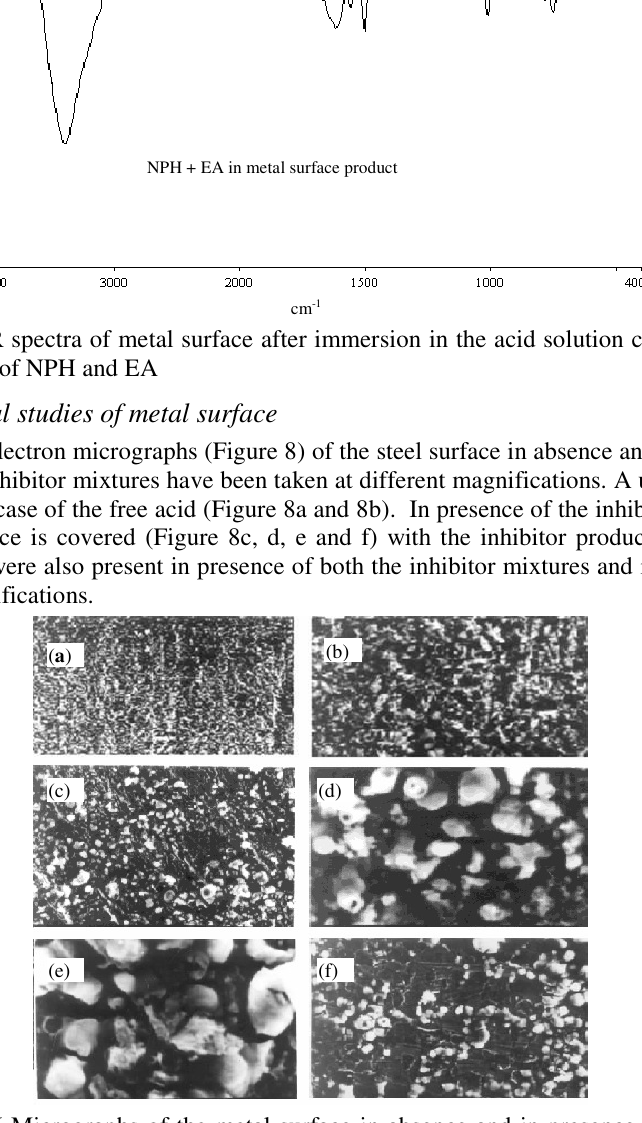
Figure 8. SEM Micrographs of the metal surface in absence and in presence of the binary inhibitor mixtures at different magnifications (a) Blank at 1000X; (b) Blank at 5000X; (c) NPH + DMA at 1000X; (d) NPH + DMA at 5000X; (e) NPH + EA at 1000X and (f) NPH + EA at 5000X (1000X and